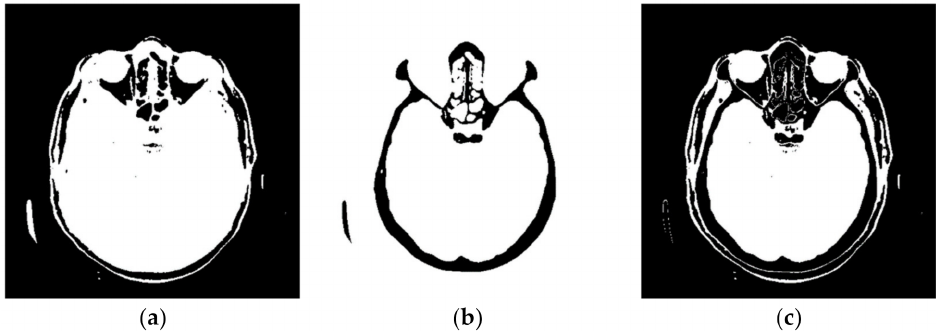
Figure 5. Pixels that do not contain useful information: ( a ) black represents the pixels that have a value of 0; ( b ) black represents the pixels that have a value > 100; and ( c ) black represents the pixels that have a value of 0 and a value > 100.